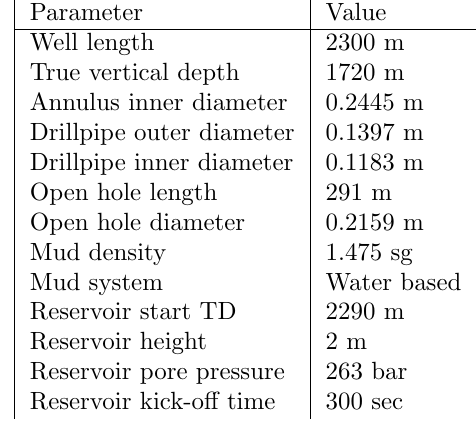
Table 1: Well geometry and fluid data in Well 1